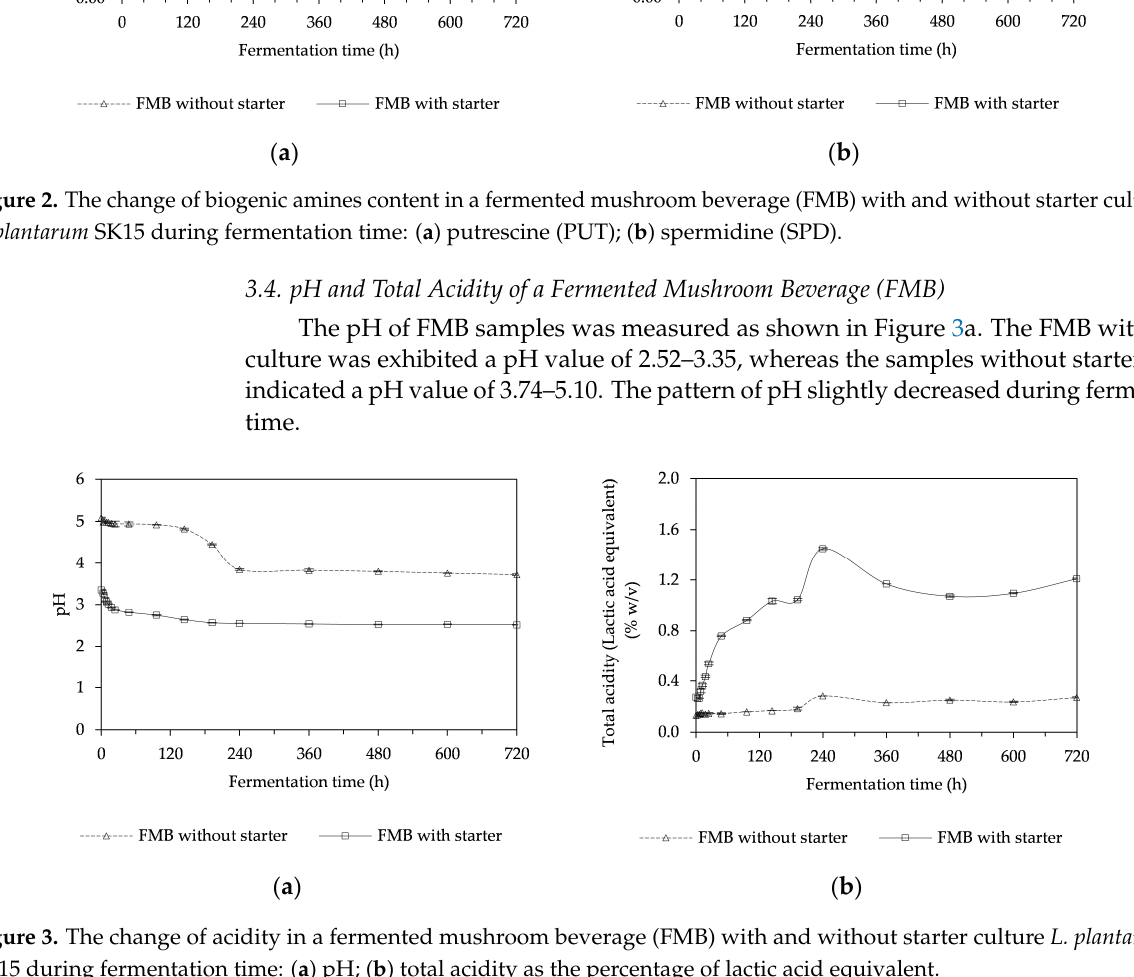
Figure 2. The change of biogenic amines content in a fermented mushroom beverage (FMB) with and without starter culture L. plantarum SK15 during fermentation time: ( a ) putrescine (PUT); ( b ) spermidine (SPD).